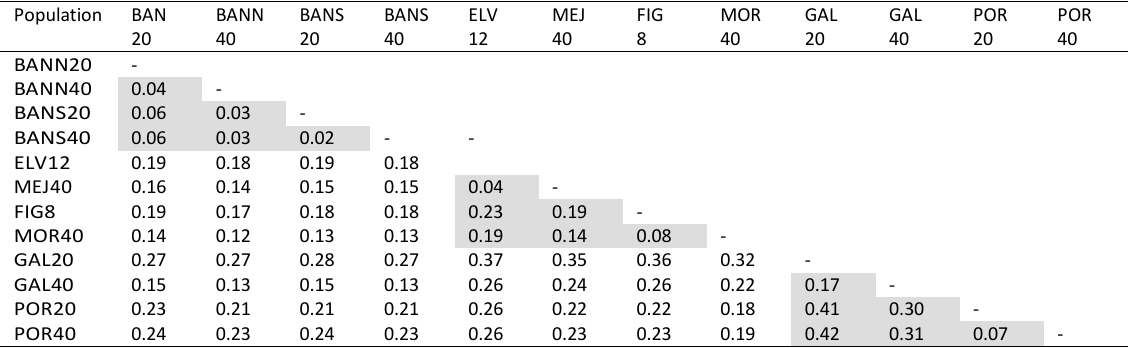
Table S2. Pairwise F ST estimates using only outlier SNPs from the ARLEQUIN analysis. All comparisons were highly significant. Intra-region comparisons are